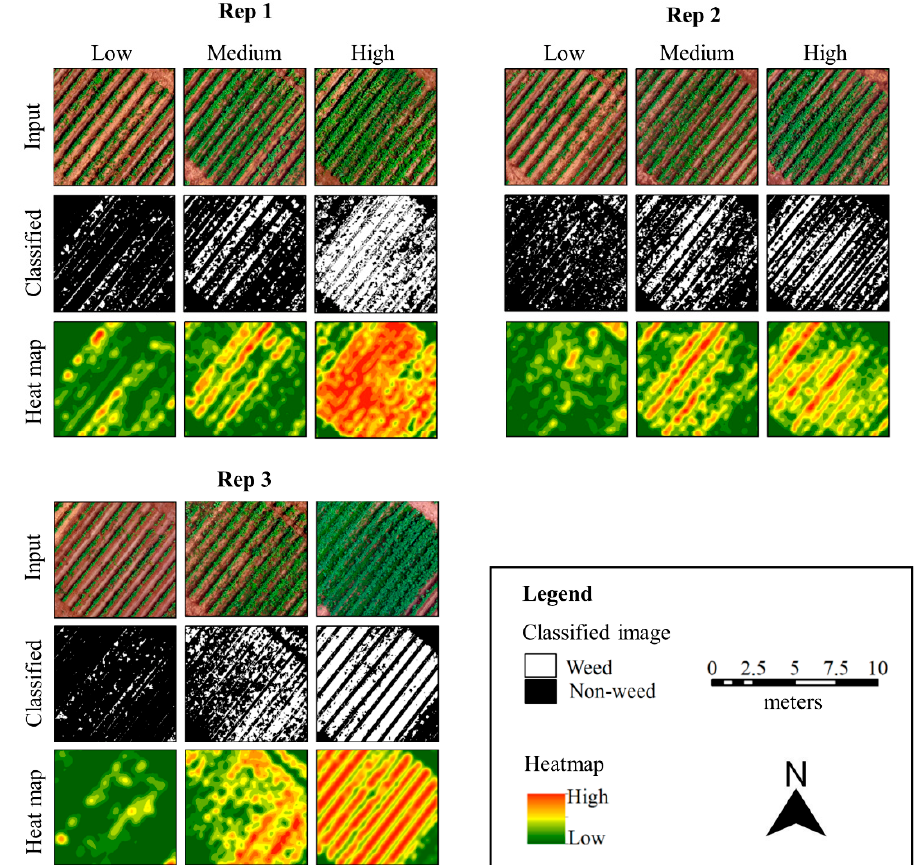
Figure 6. Results showing weed coverage in each replication (Rep 1, Rep 2, and Rep 3 on the upper-left, upper-right, and bottom-left panels, respectively) for three different density treatment plots (low, medium, and high). The pixels pertaining to weeds and crop in the classified maps were analysed using a multi-step approach involving separation of inter-row weeds first using Hough transformation and then detection of intra-row weeds using random forest classifier. The weed pixel density heat maps were derived by first converting the classified pixels to point shape files and performing point kernel density analysis on the shapefiles.